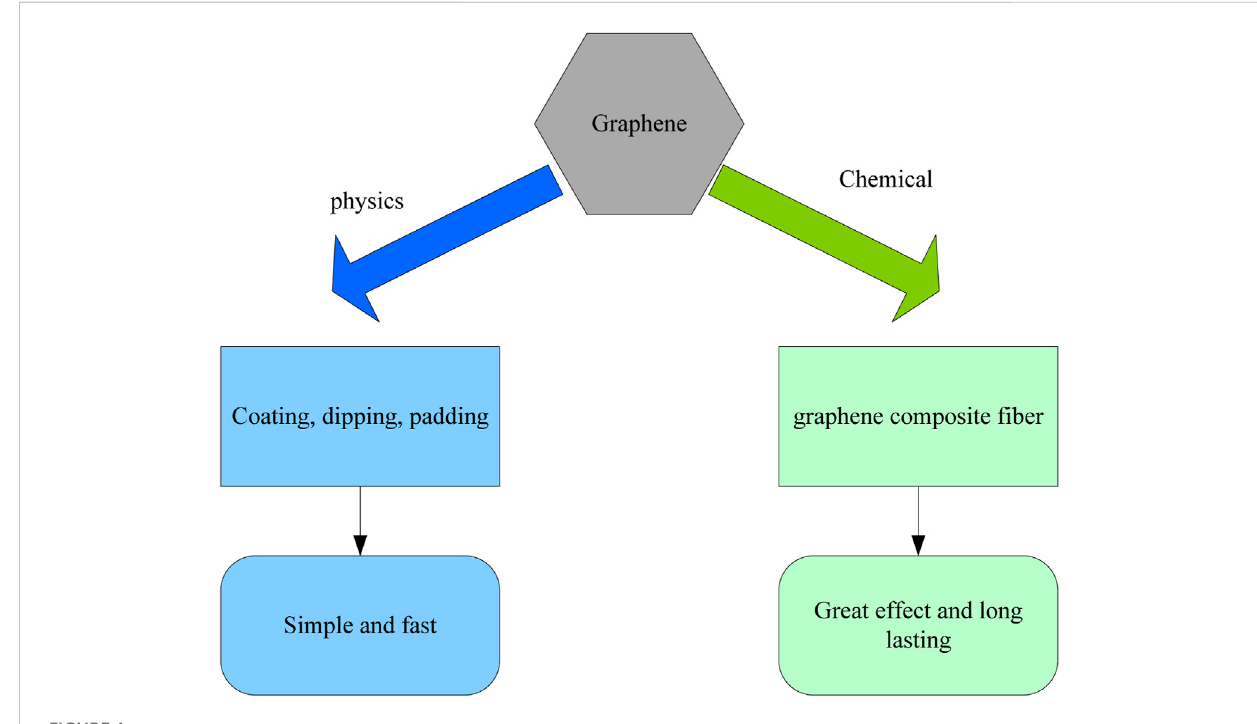
FIGURE 1 Graphene used in